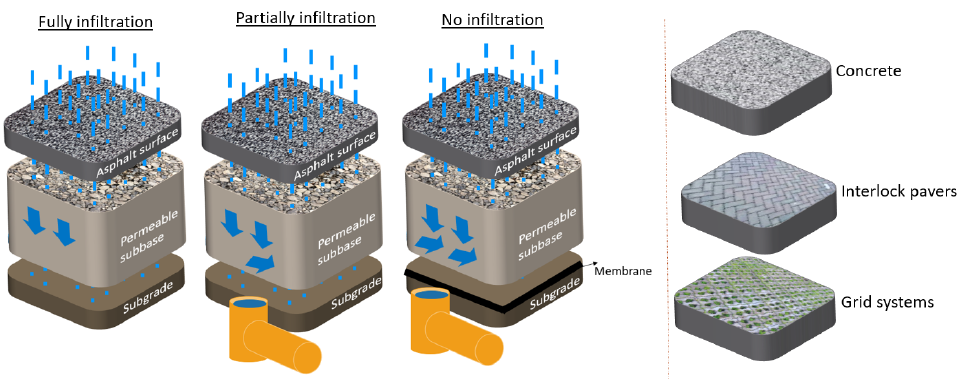
Figure 3. Full infiltration, partial infiltration and no infiltration system. The surface layer can be changed according to the purpose.